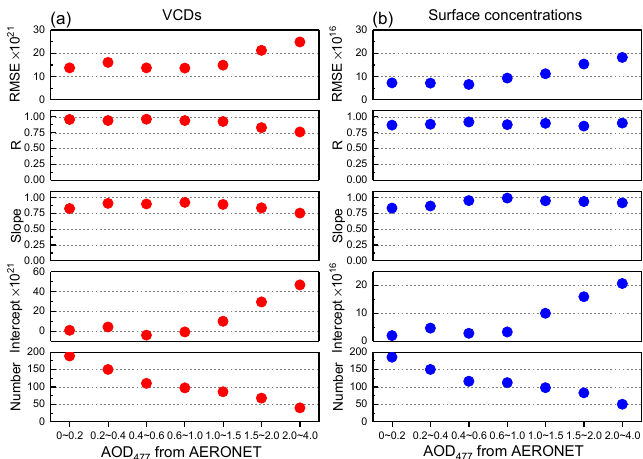
Figure 11. ( a ) Validation results for MAX-DOAS VCDs with AERONET measurements under different AOD levels. The root mean square errors (RMSEs) calculated from the two datasets, correlation coefficients (R), slopes, and intercepts derived using linear regression, and the corresponding numbers of data points under different aerosol optical depth (AOD) levels are displayed as red dots. ( b ) As ( a ), but for the correlation between surface concentrations retrieved from MAX-DOAS and NCDC in-situ instruments.